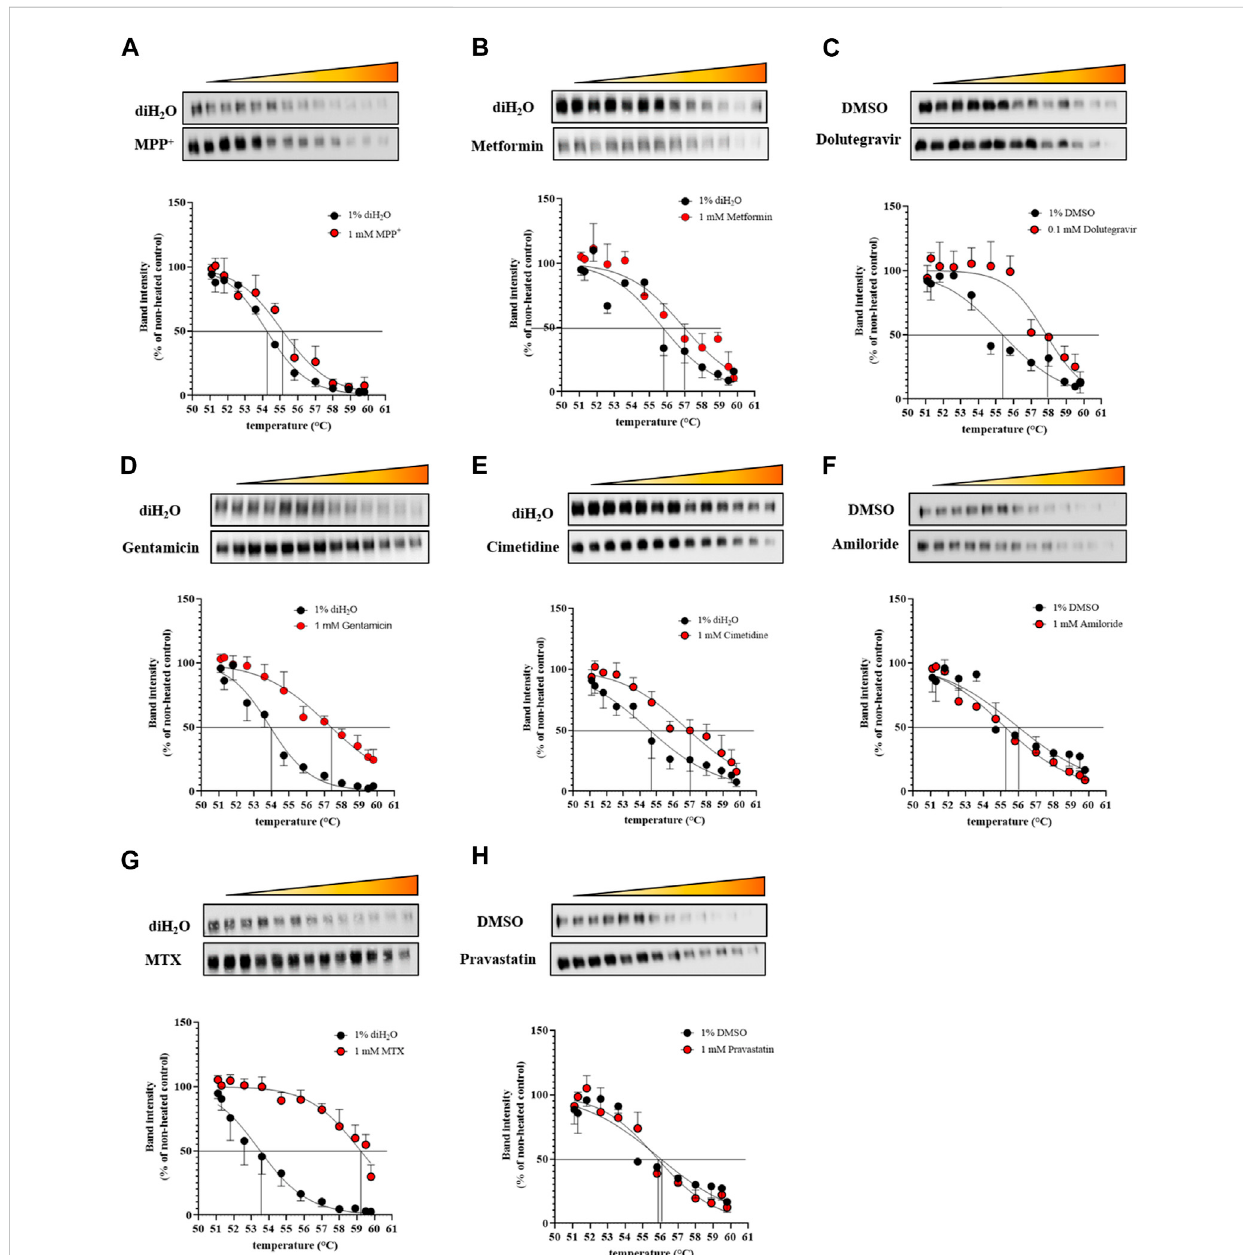
FIGURE 5 Melting curves of OCT2. DDM-solubilized membranes containing the human OCT2 were exposed to the indicated ligands at the concentration of 1 mM. Representative Western blot and relative quanti fi cation of the OCT2 remaining in solution after heating and centrifugation. Melting curves were generated from densitometric values at 12 different temperatures normalized to that of the non-heated control and fi tted to a dose – normalized response equation with a variable Hill